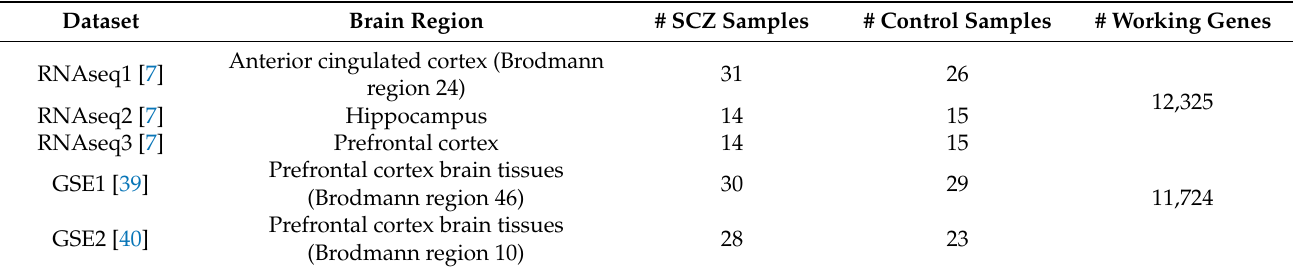
Table 1. Basic information of five gene expression